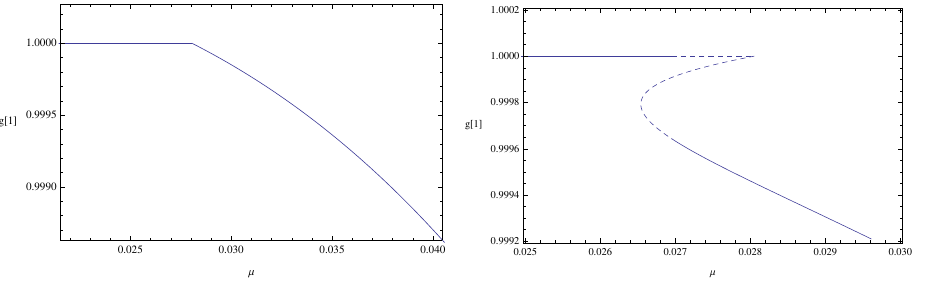
Figure 6 . (Color online) We show g (1) with respect to chemical potential µ . In the left panel, the curve is with phases of q = 100, m 2 = − 2 and C 4 = 0 and the right panel represents cases of q = 4, m 2 = − 2 and C 4 = 0 . 1. We show stable phases with solid curves and unstable phases with dashed